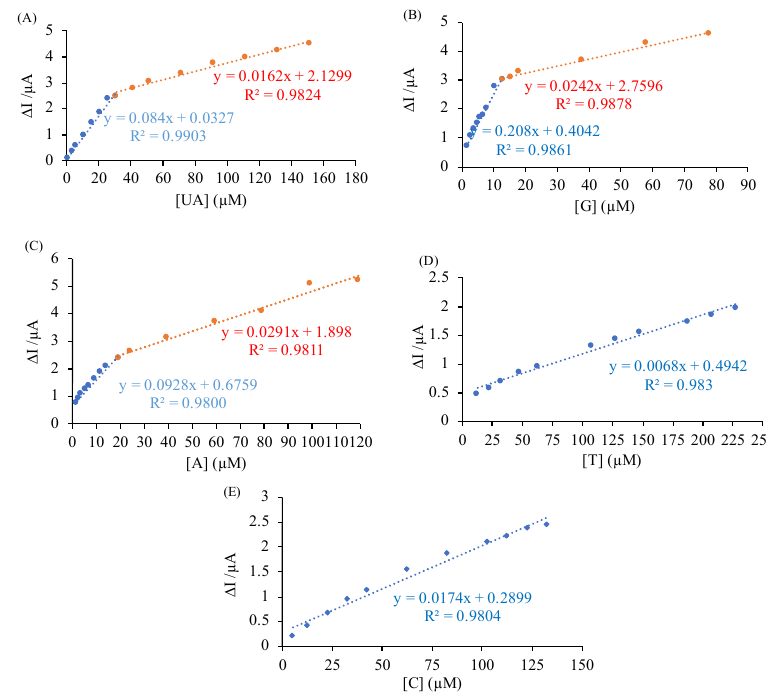
Figure 8. Calibration graphs for UA ( A ) and all four nucleobases ( B – E ), respectively.